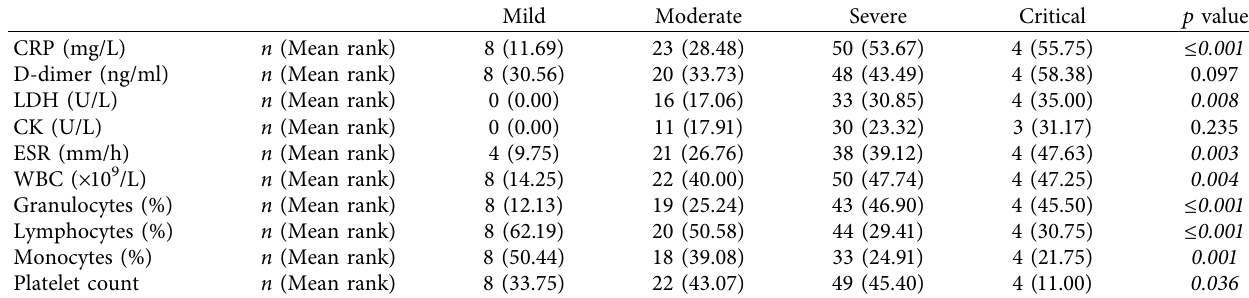
Table 4: Distribution of biochemical and hematological parameters across disease severity groups.